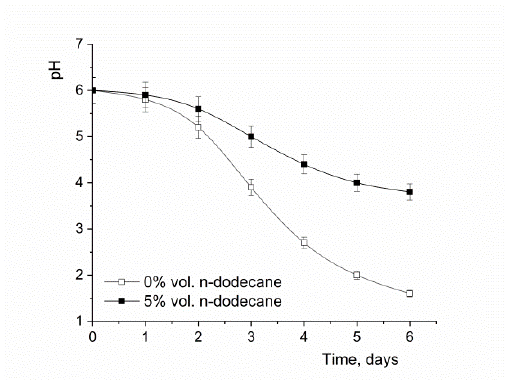
Figure 1. Comparison between the pH-values during the fermentation in absence and presence of n -dodecane.